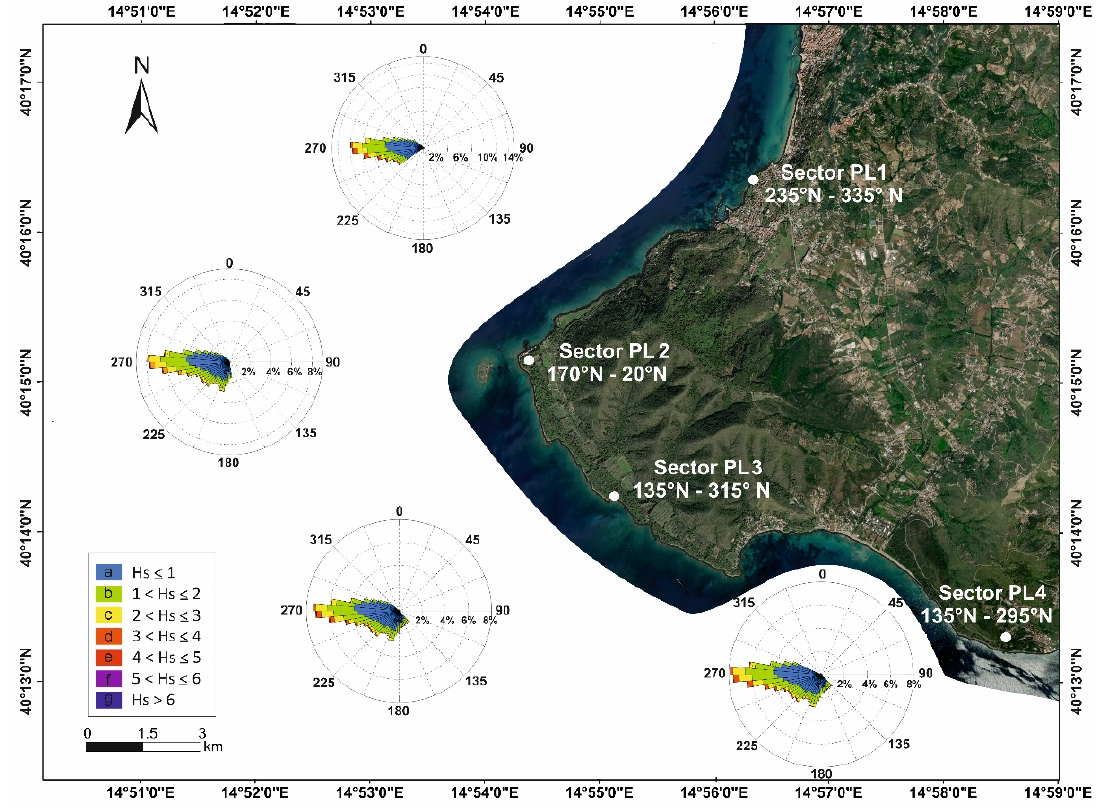
Figure 9. Signi fi cant wave height roses obtained for PL1-PL4 sectors. Figure 9. Significant wave height roses obtained for PL1-PL4